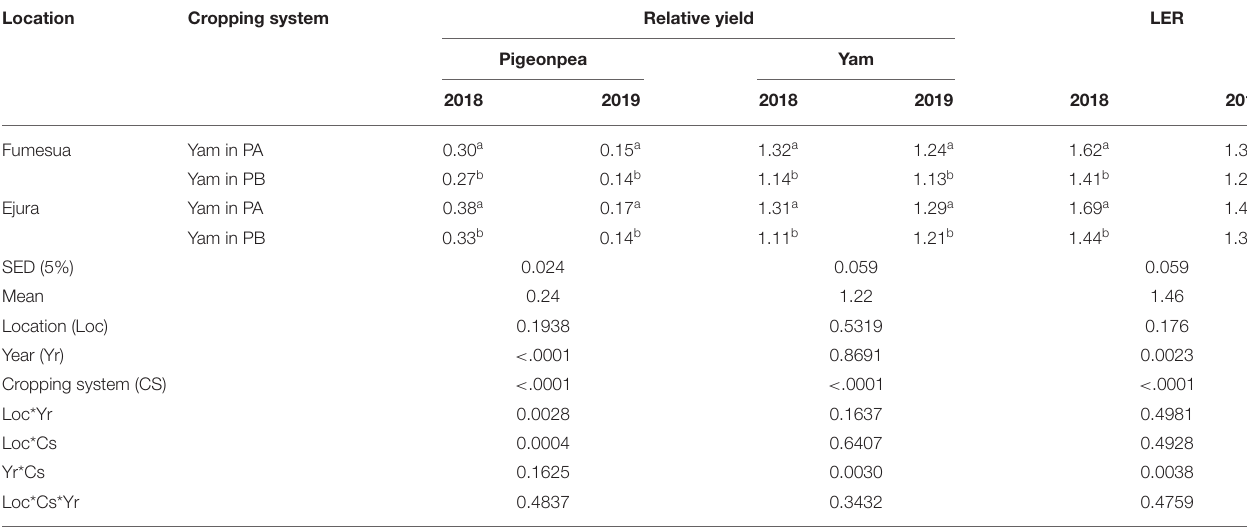
TABLE 1 | The land equivalent ratio (LER) of the pigeonpea–yam cropping system at Fumesua and Ejura for 2018 and 2019 cropping seasons. Location Cropping system Relative yield LER Pigeonpea